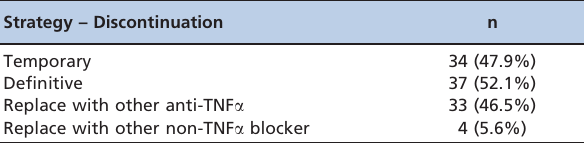
Table 5 - Strategies used regarding immunobiological agents following adverse skin